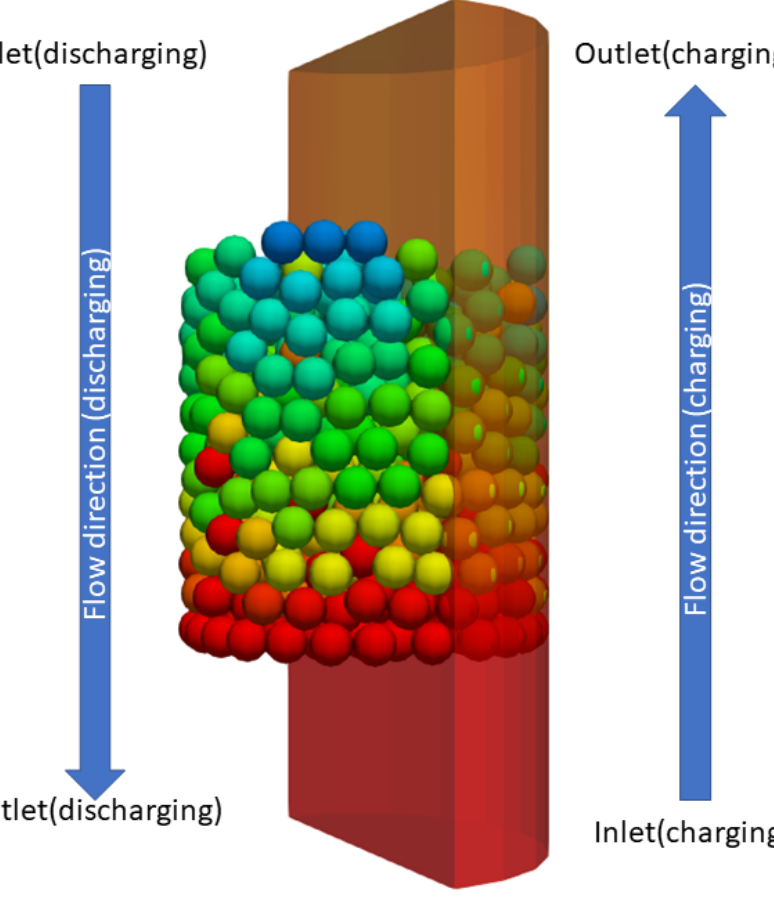
Figure 5. Half of the CFD domain with the DEM domain